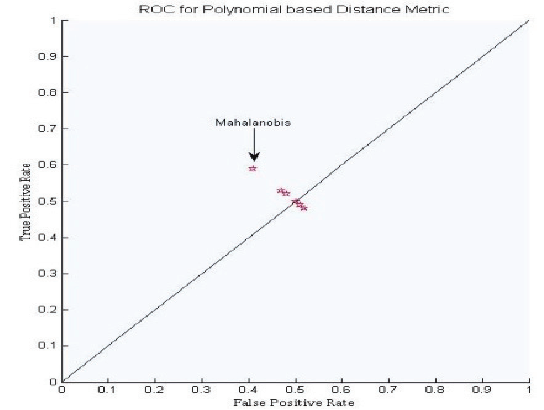
Fig. 18. ROC space for polynomial based distance